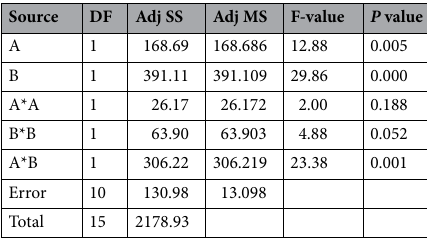
Table 3. ANOVA for